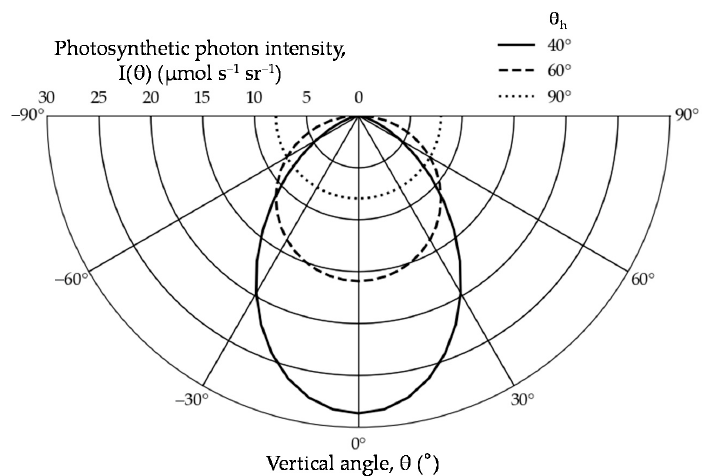
Figure 8. The photometric curves from the conditions of N = 6 and θ h = 40°, 60°, and 90°. I( θ ), θ , θ h , and N are the photosynthetic photon intensity, vertical angle, the half-value angle, and the number of BRLED lamps,